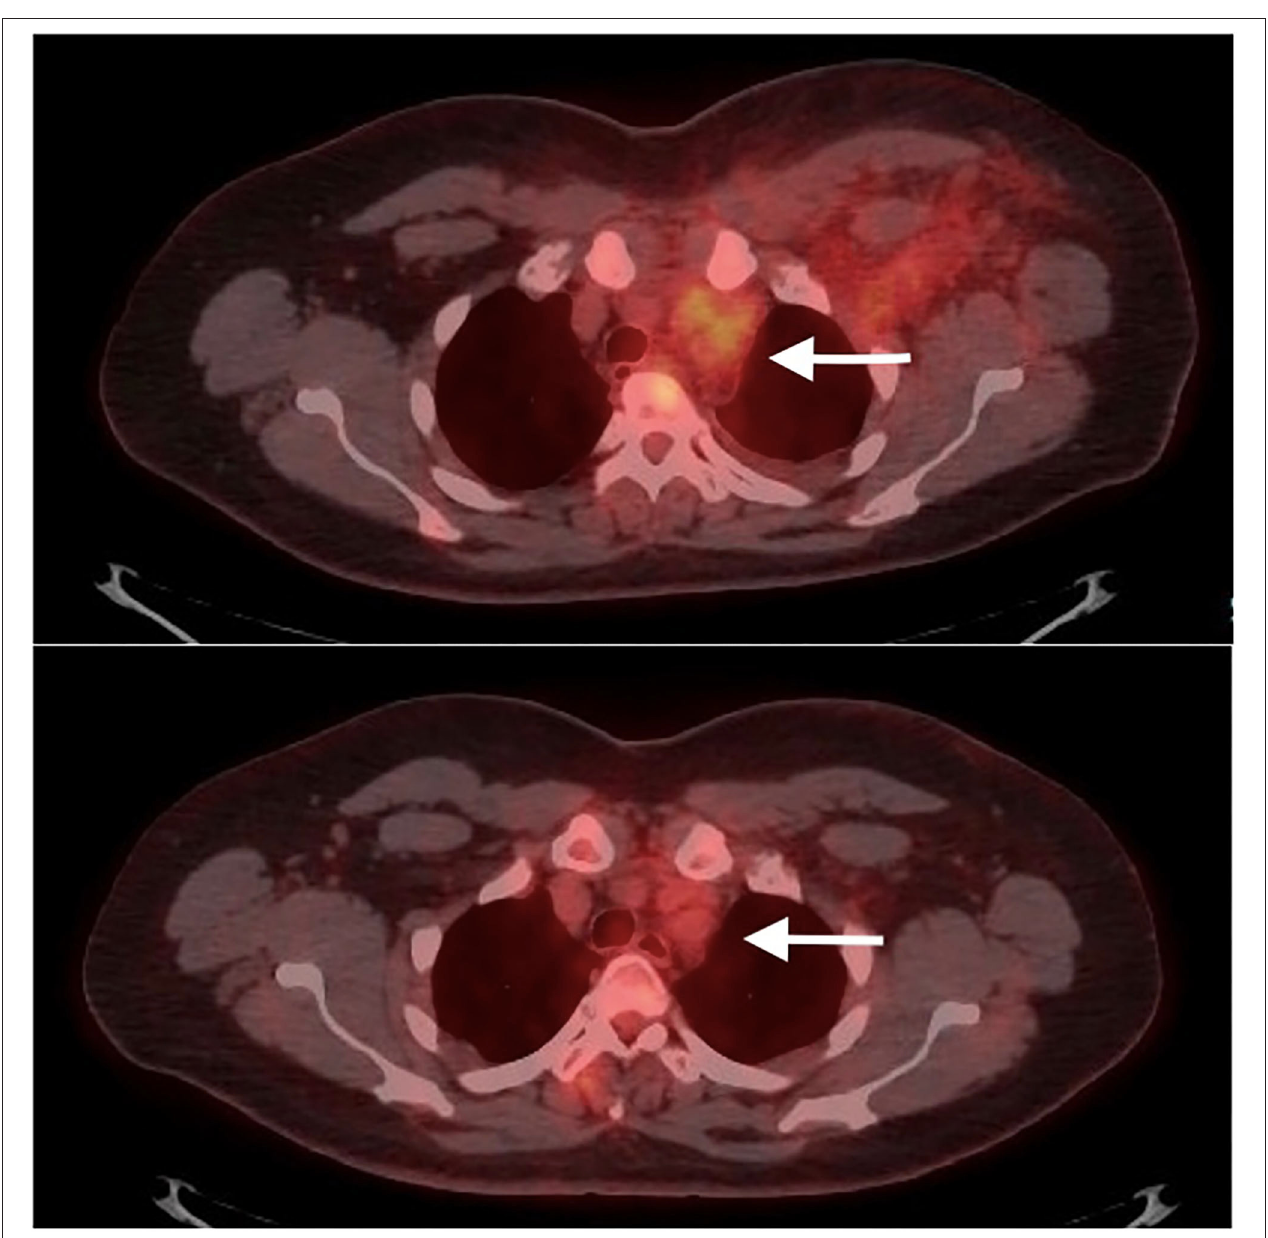
FIGURE 2 | The mediastinal positive PET-CT scan mediastinal mass (above) disappeared after 46 days (below), at the resolution of the SARS-CoV-2.